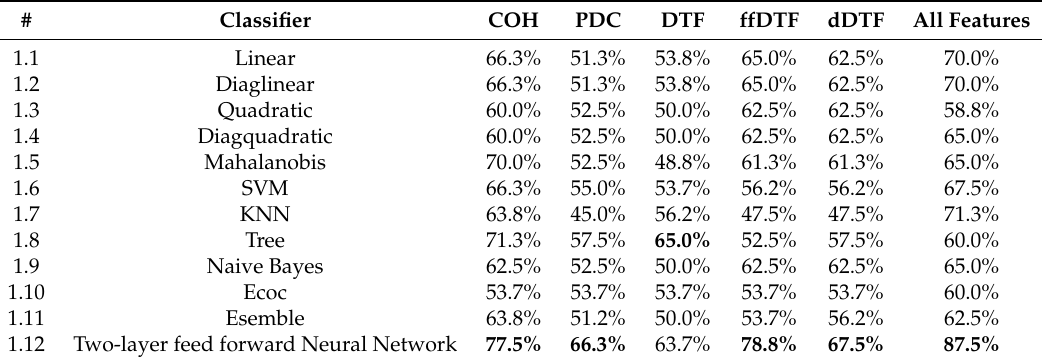
Table 3. Classification accuracy results. Abbreviations: COH, Coherence; pCOH, Partial coherence; PDC, Partial directed coherence; DTF, Directed transfer function; dDTF, Direct directed transfer function; ffDTF, Full frequency directed transfer